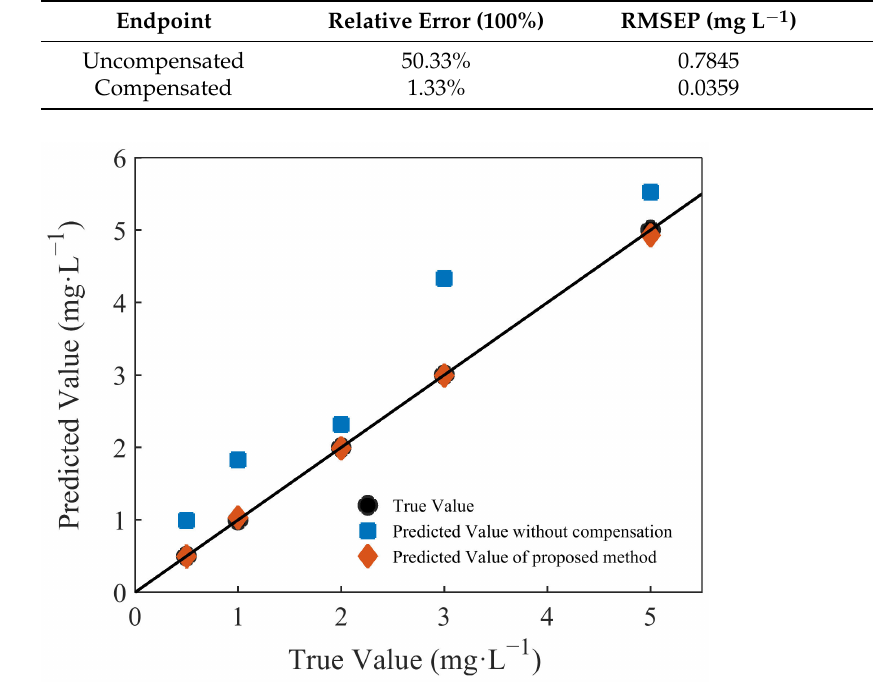
Table 2. Prediction results of mixed samples before and after turbidity compensation.